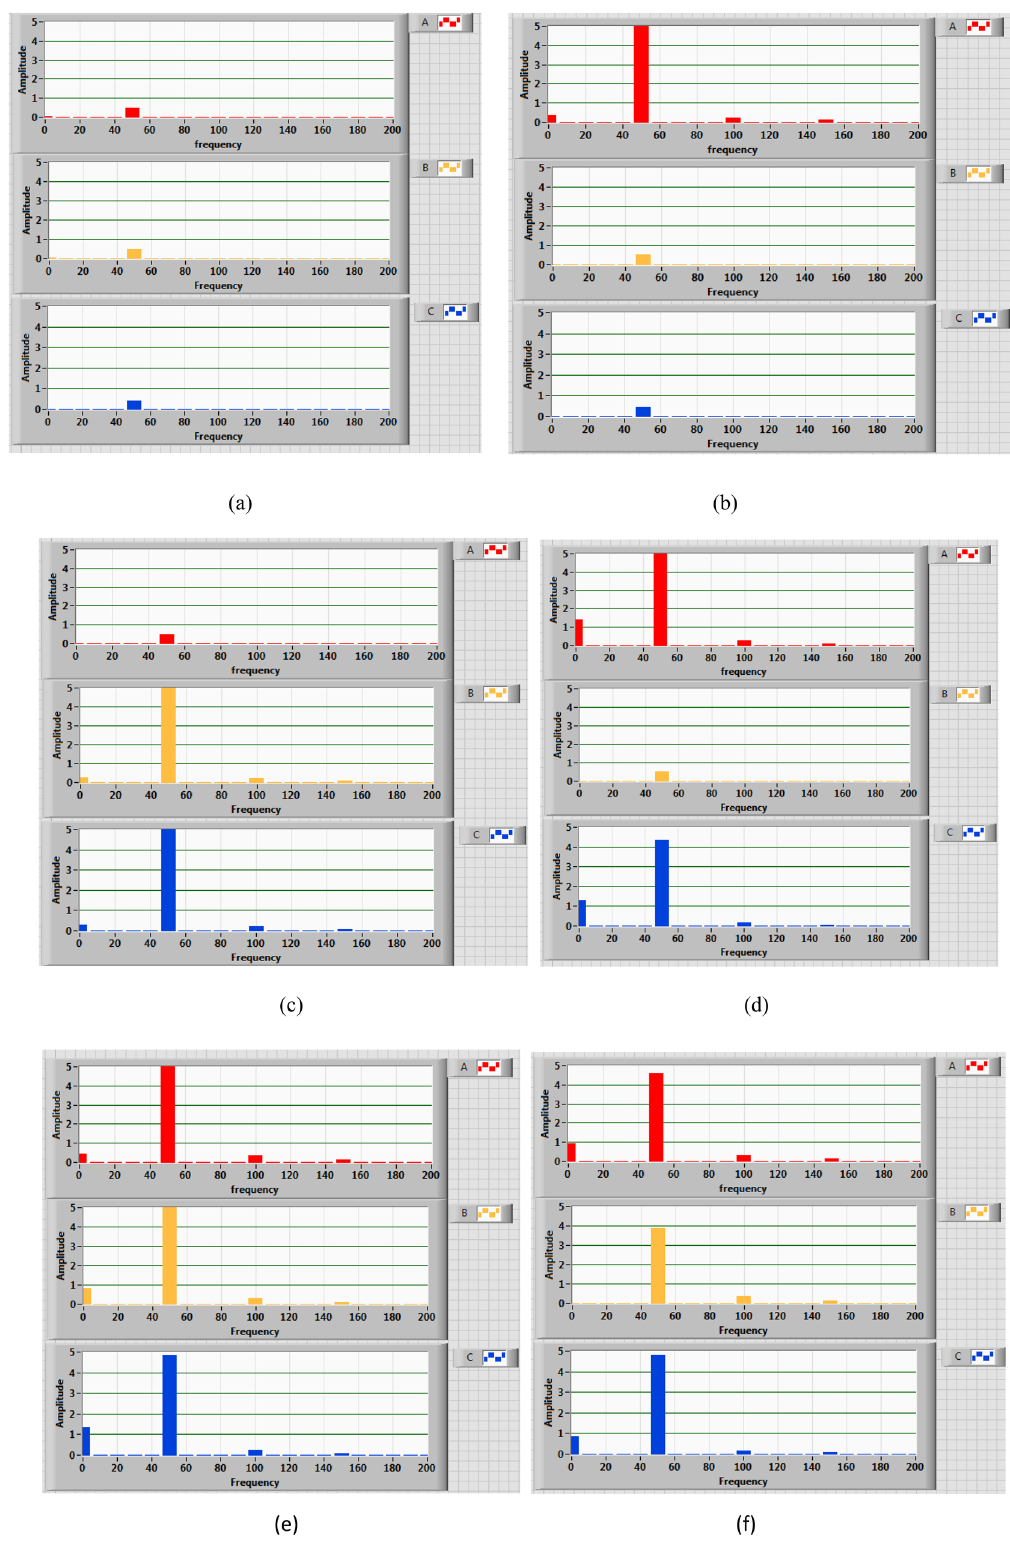
Fig. 5 Frequency spectrum for different type of fault at a Normal operation b LG fault c LL Fault d LLG fault e LLL fault f LLLG